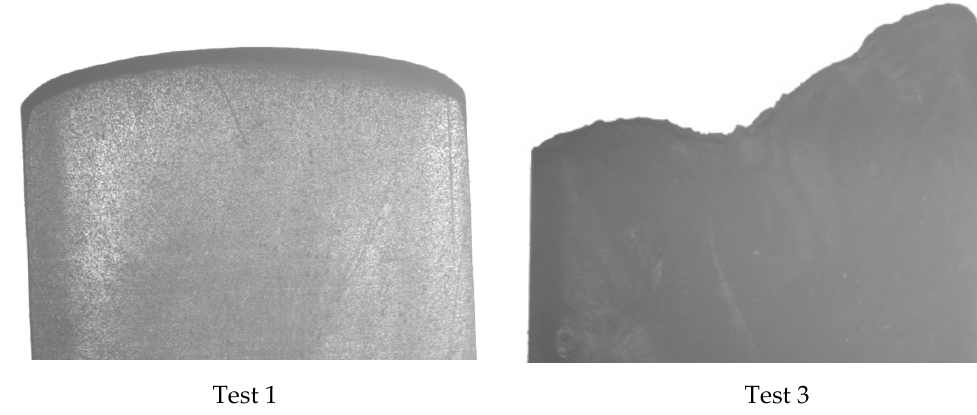
Figure 10. Flow fronts for test parts 1 and 3.